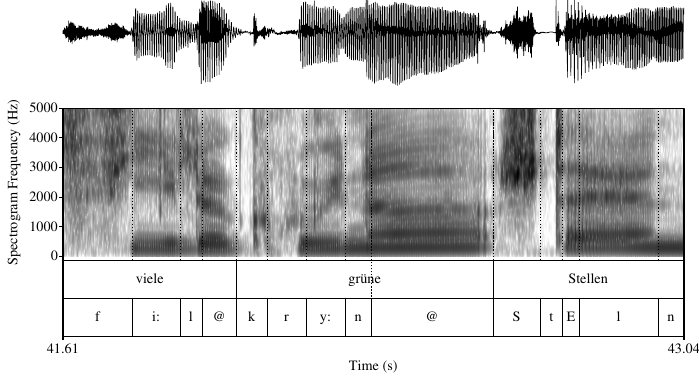
Figure 4. Lengthening of schwa (@) in grüne ‘green’ in the phrase viele grüne Stellen ‘a lot of green patches’, showing a graphematic layer and a segmental layer (source: